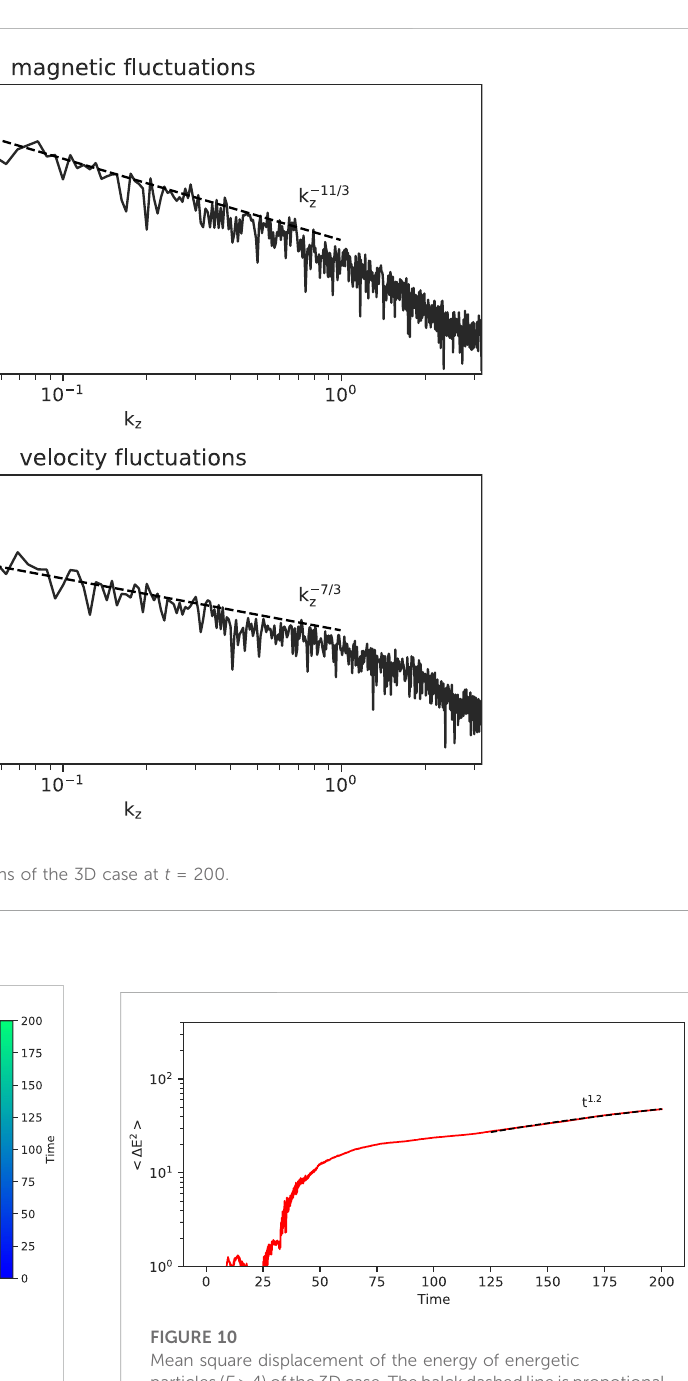
FIGURE 9 Time evolution of the energy distribution of test particles in the 3D case. The black dashed line is a Kappa distribution with a temperature of T κ = 0.8 and a Kappa index of κ = 4.2.